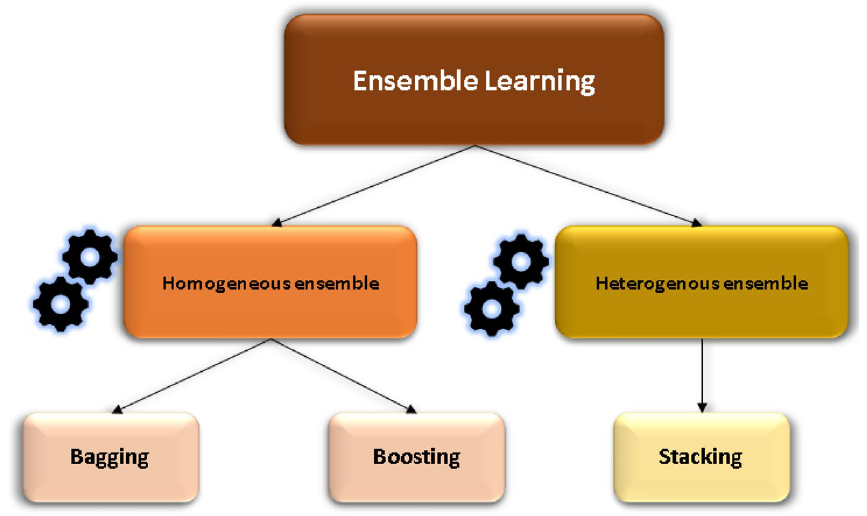
Figure 2. Classification of ensemble learning